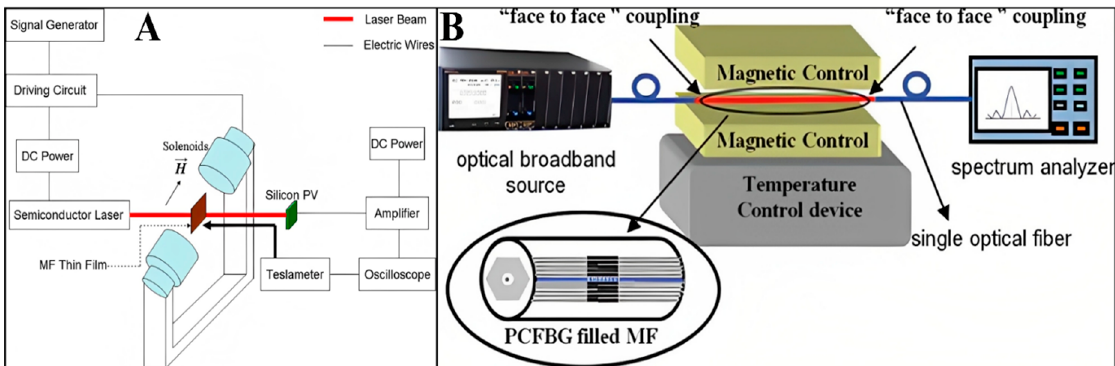
Figure 8. ( A ) Schematic diagram of experimental arrangement for realizing temperature sensor using an FN thin film. Reprinted with permission from Ref. [82]. Copyright 2008, Springer Nature ( B ) setup used for estimating magnetic field and temperature using PCFBG loaded with magnetic nanofluid. Reprinted with permission from Ref. [83]. Copyright 2013, Taylor & Francis.